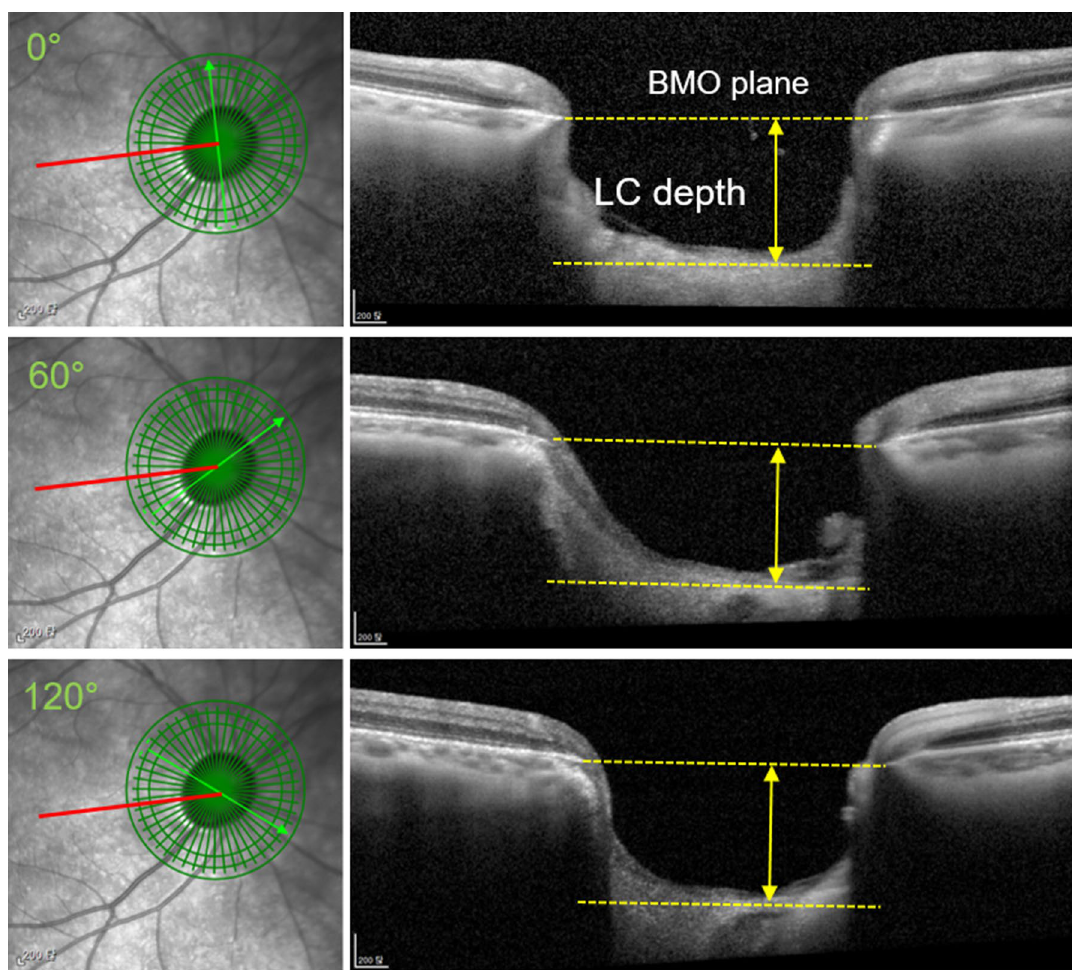
Figure 3. Measurement of lamina cribrosa (LC) depth using optical coherence tomography. The FoBMO axis (red line) was defined as the line connecting the center of the Bruch’s membrane opening (BMO) and fovea. A vertical line to the FoBMO axis passing through the center of the BMO was defined as 0°, and the LC depth was measured manually at 0°, 60°, and 120° clockwise in the right eye. LC depth (yellow solid line) was defined as the maximum perpendicular distance between the plane connecting both BMOs and the anterior surface of the LC (yellow dotted